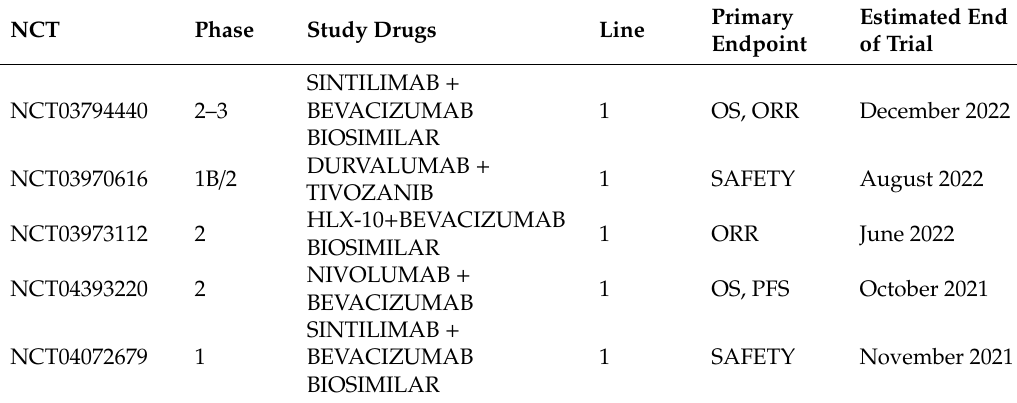
Ongoing clinical trials that explore the combination of PD1 inhibitors and intravenous anti-VEGF (vascular endothelial growth factor) agents as treatment for advanced hepatocellular